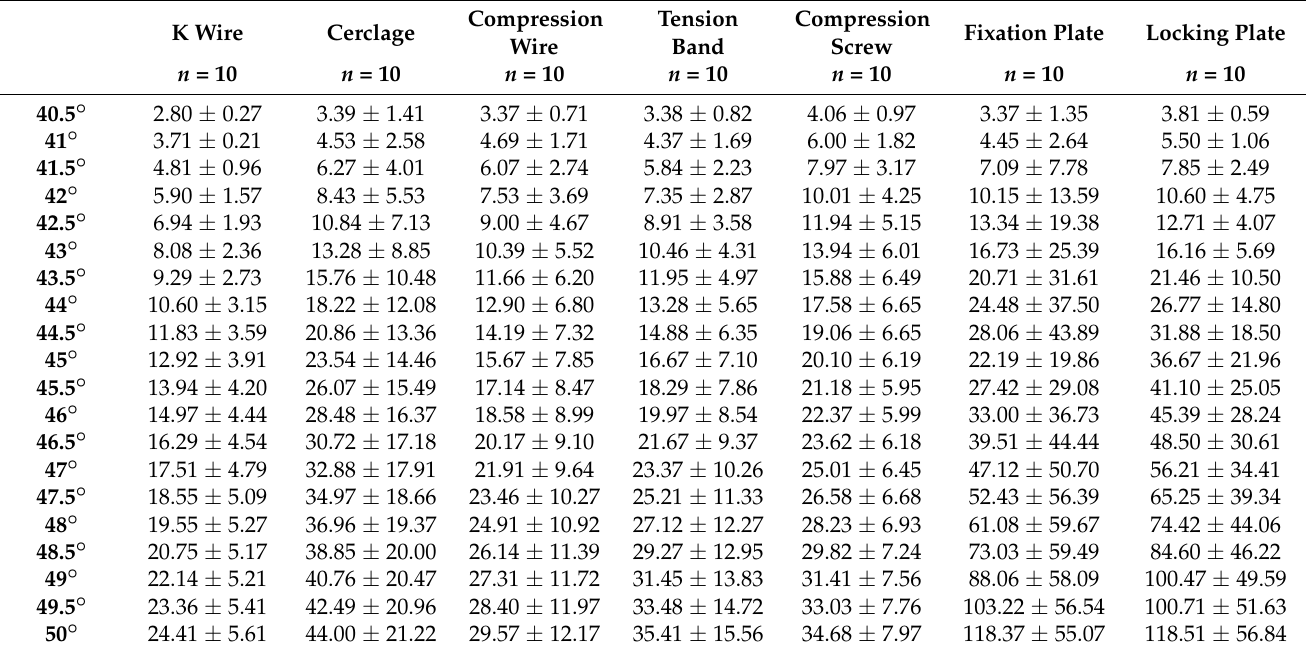
Table 2. Flexion of PIP joint arthrodesis with different